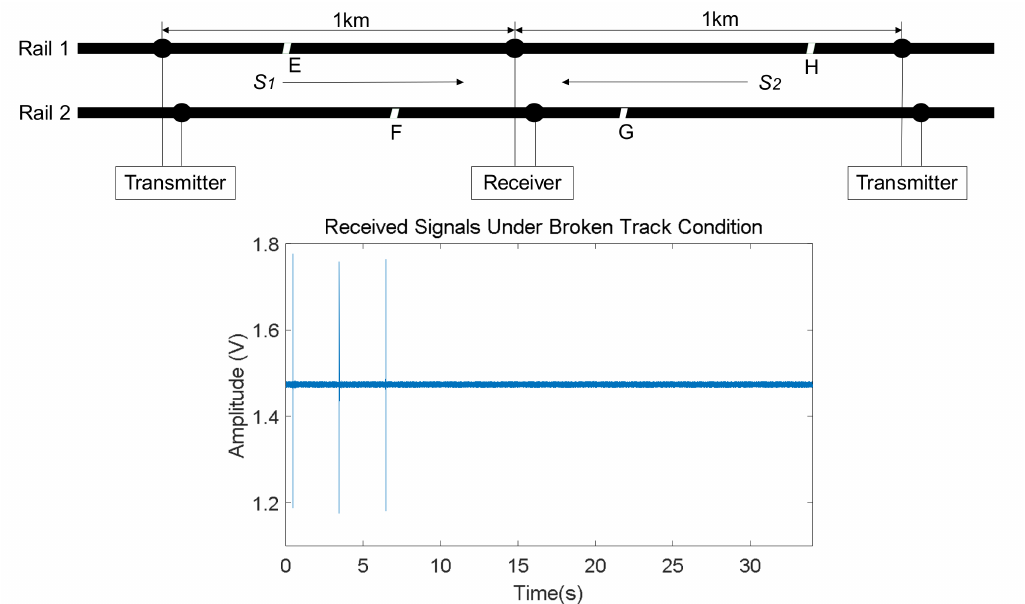
Figure 11. Diagram and example of UGW signals received in rail no. 2 for a broken track section.